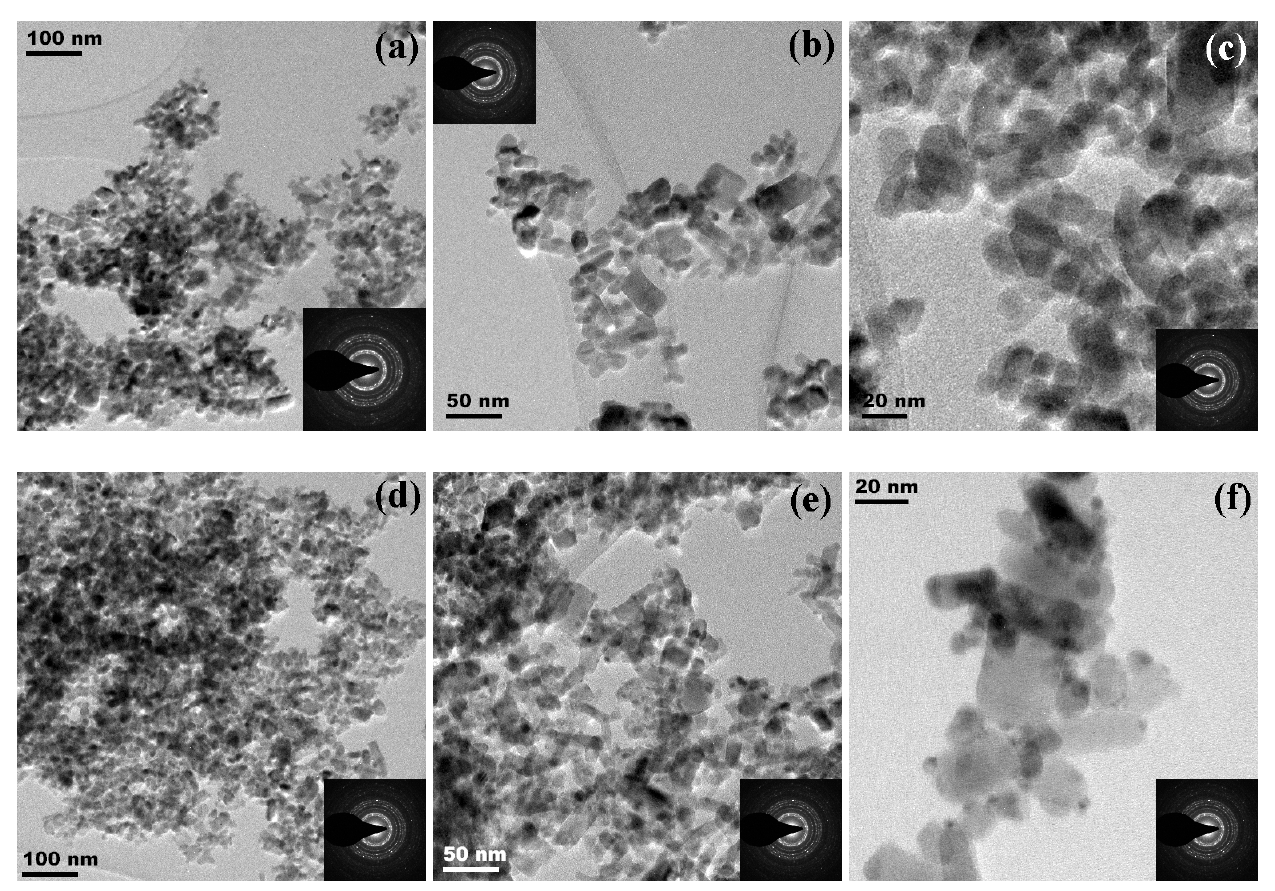
Figure 8 (a-c) show HR-TEM bright-fields images of highly crystalline flame-made (5/5) ZnO nanoparticles (P0) and (d-f) 5 mol% Pd/ZnO nanoparticles (P5) with different magnifications. Insets show the corresponding diffraction patterns of the